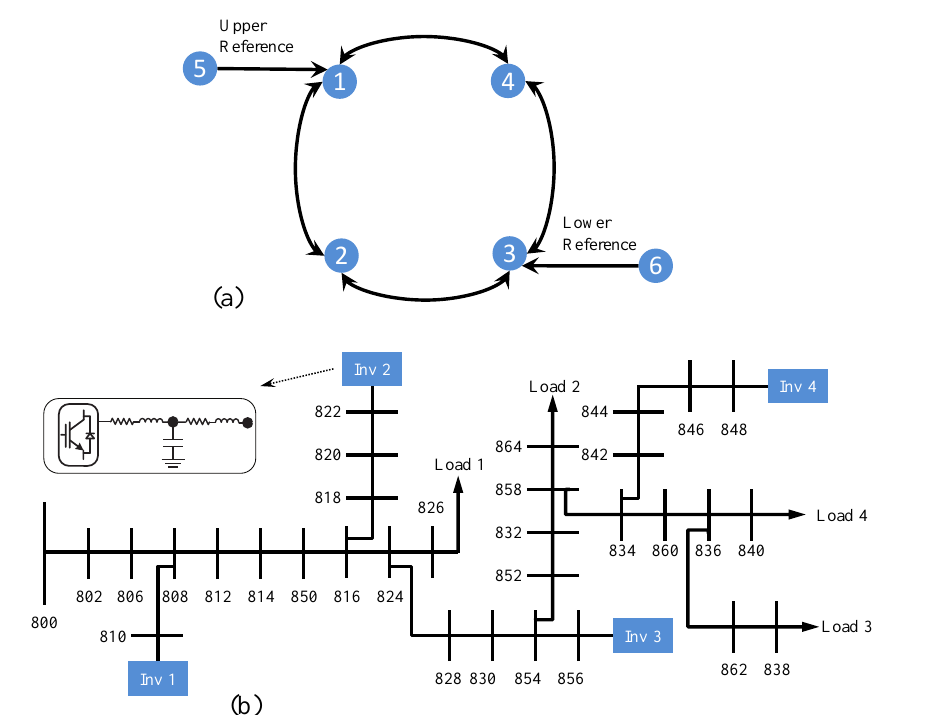
Figure 3. Cyber–physical microgrid system: ( a ) communication graph topology among four inverters and two leaders and ( b ) IEEE 34-bus system with four inverters.